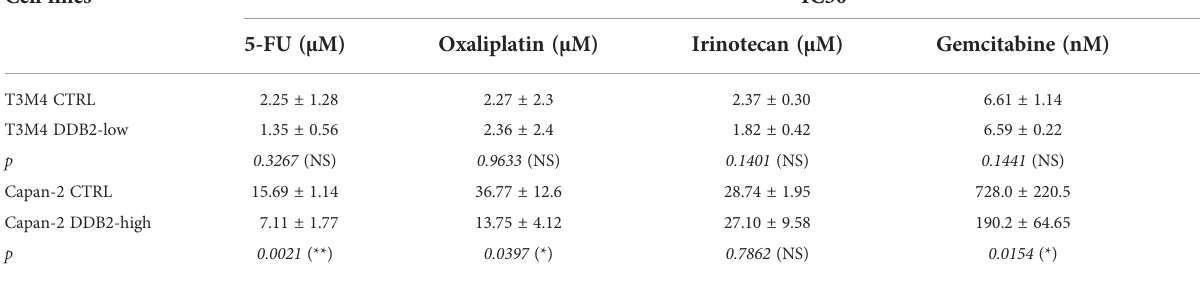
TABLE 2 Calculated IC50 of 5-FU, oxaliplatin, irinotecan and gemcitabine for T3M4 DDB2-low, T3M4 CTRL, Capan-2 DDB2-high and Capan-2 CTRL cells. Cell